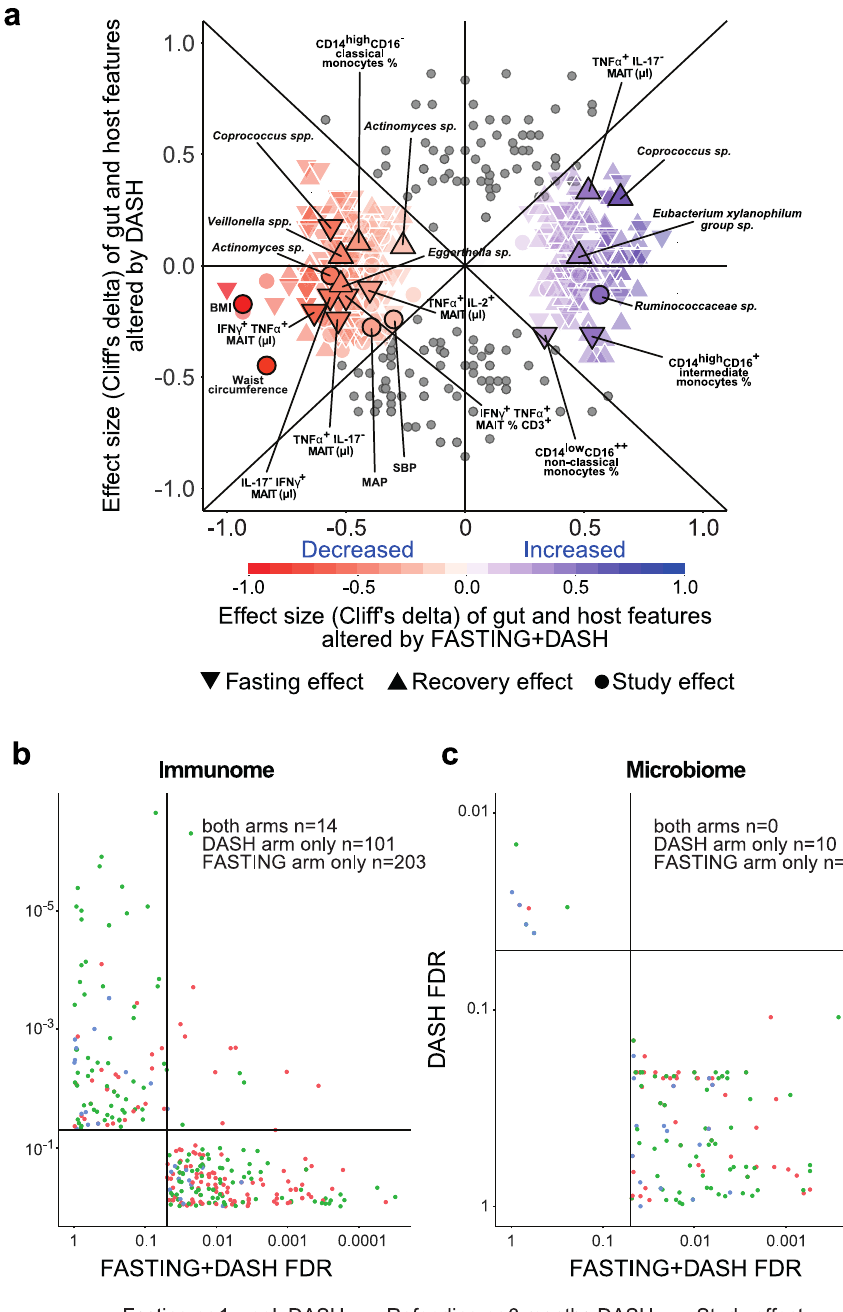
NATURE COMMUNICATIONS| (2021) 12:1970 |https://doi.org/10.1038/s41467-021-22097-0|www.nature.com/naturecommunications